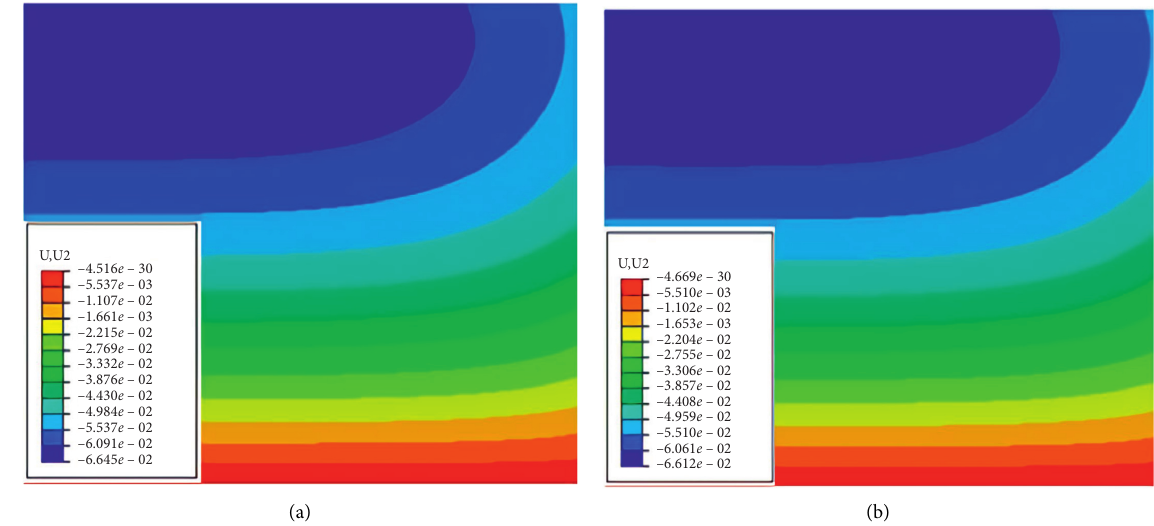
Figure 5: The distribution nephogram of vertical displacement